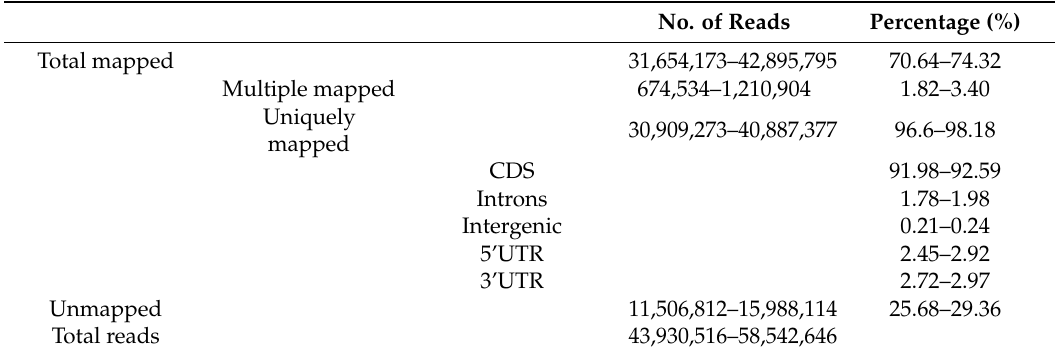
Table 1. Statistics of RNA-seq read